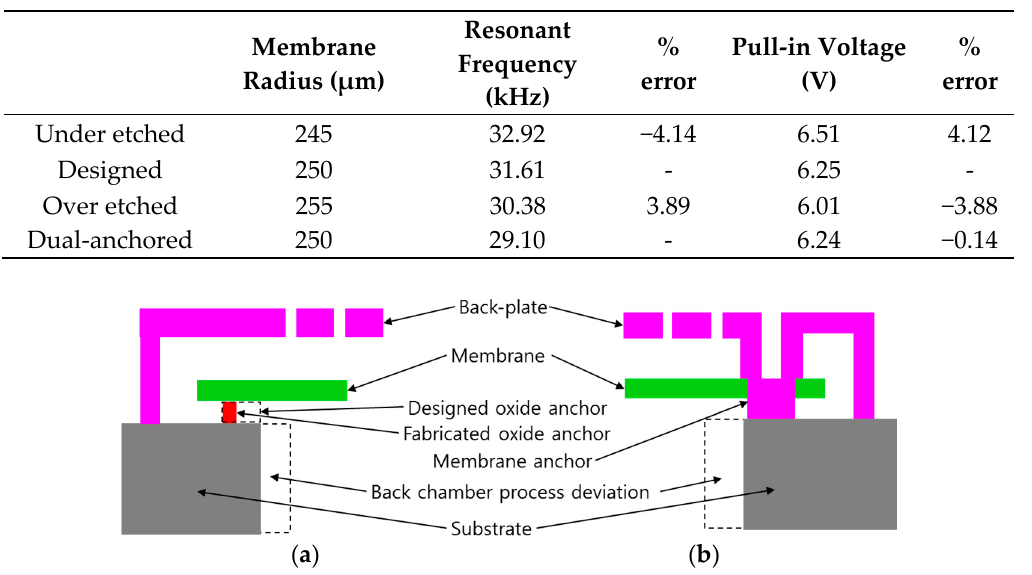
Figure 2. Cross-sectional view of: ( a ) Oxide anchored membrane; ( b ) Dual anchored